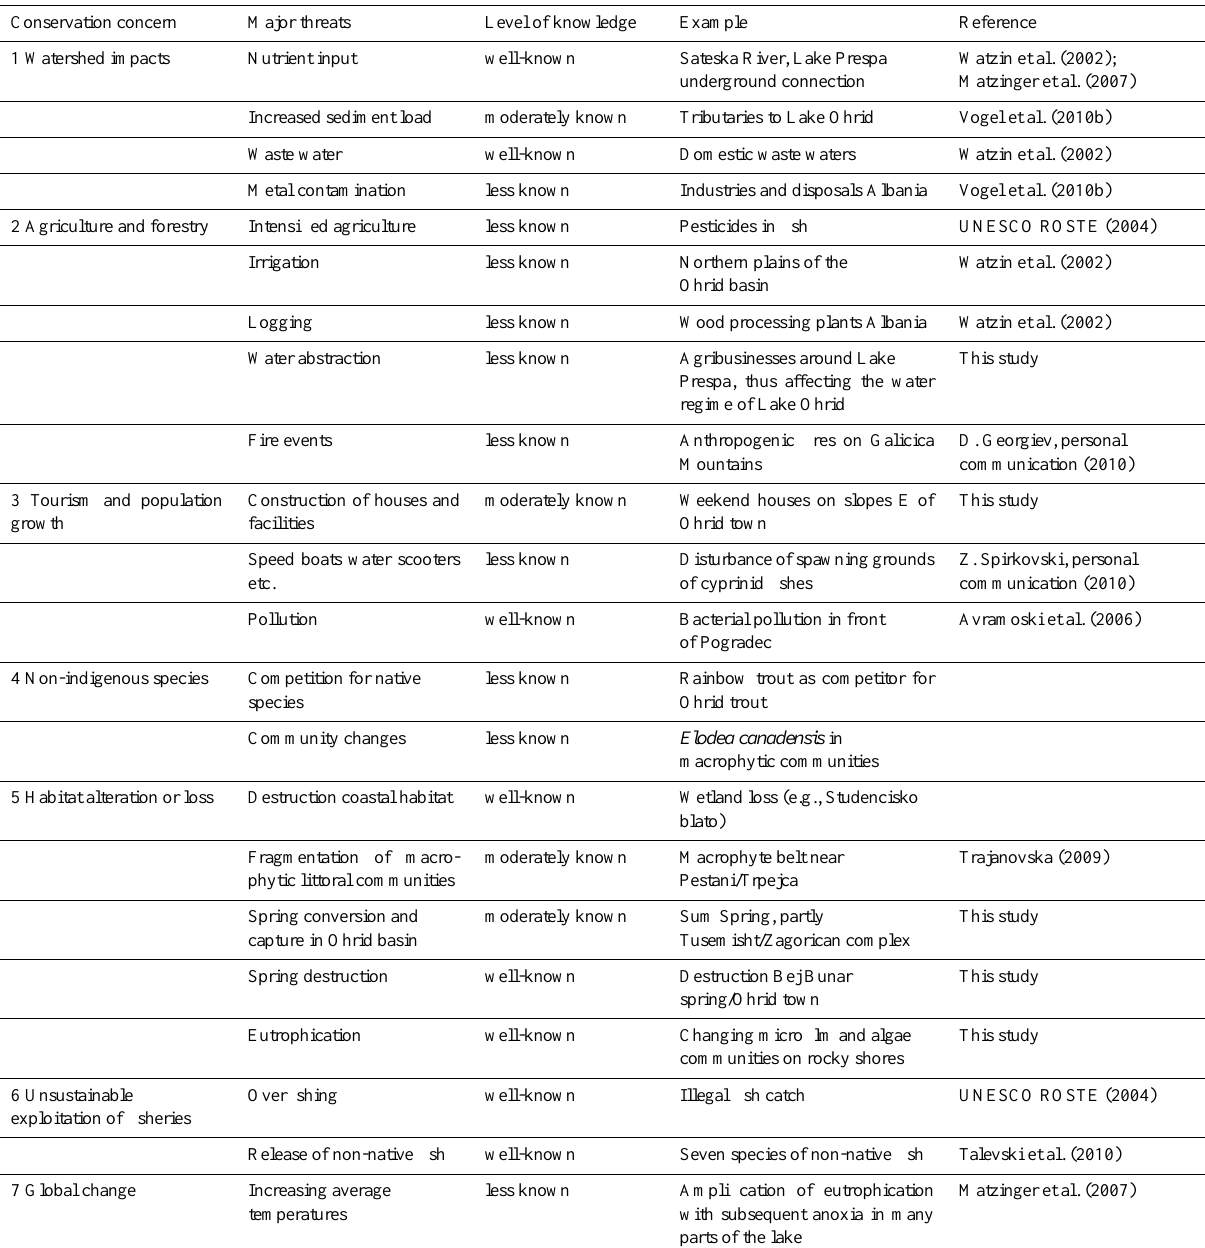
Table 2. Conservation concerns and associated major threats identified for Lake Ohrid. The level of knowledge regarding these threats is subjectively estimated. Examples are provided for each threat (for details see